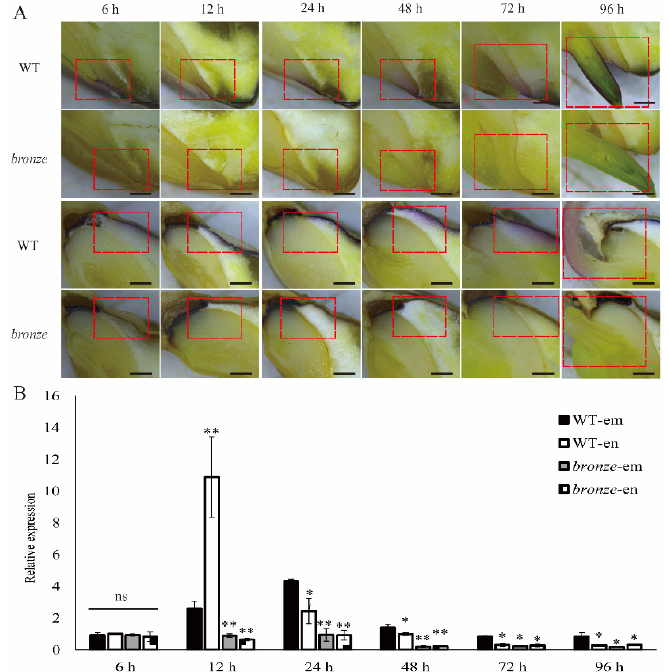
Figure 4. Anthocyanin movement and ZmBZ1 expression pattern during seed germination. ( A ) Observation of the anthocyanins movement from longitudinal sections of WT and bronze seeds that germinated for 6 h, 12 h, 24 h, 48 h, 72 h and 96 h. Red dashed rectangles highlight the location of anthocyanin accumulation. Bar = 1 mm; ( B ) qPCR analysis of ZmBZ1 expression of WT and bronze seeds during germination. GAPDH was used as an internal control. Values are shown as means ± SE, n = 3. Student t -test: * p < 0.05; ** p < 0.01; ns means no significant difference.